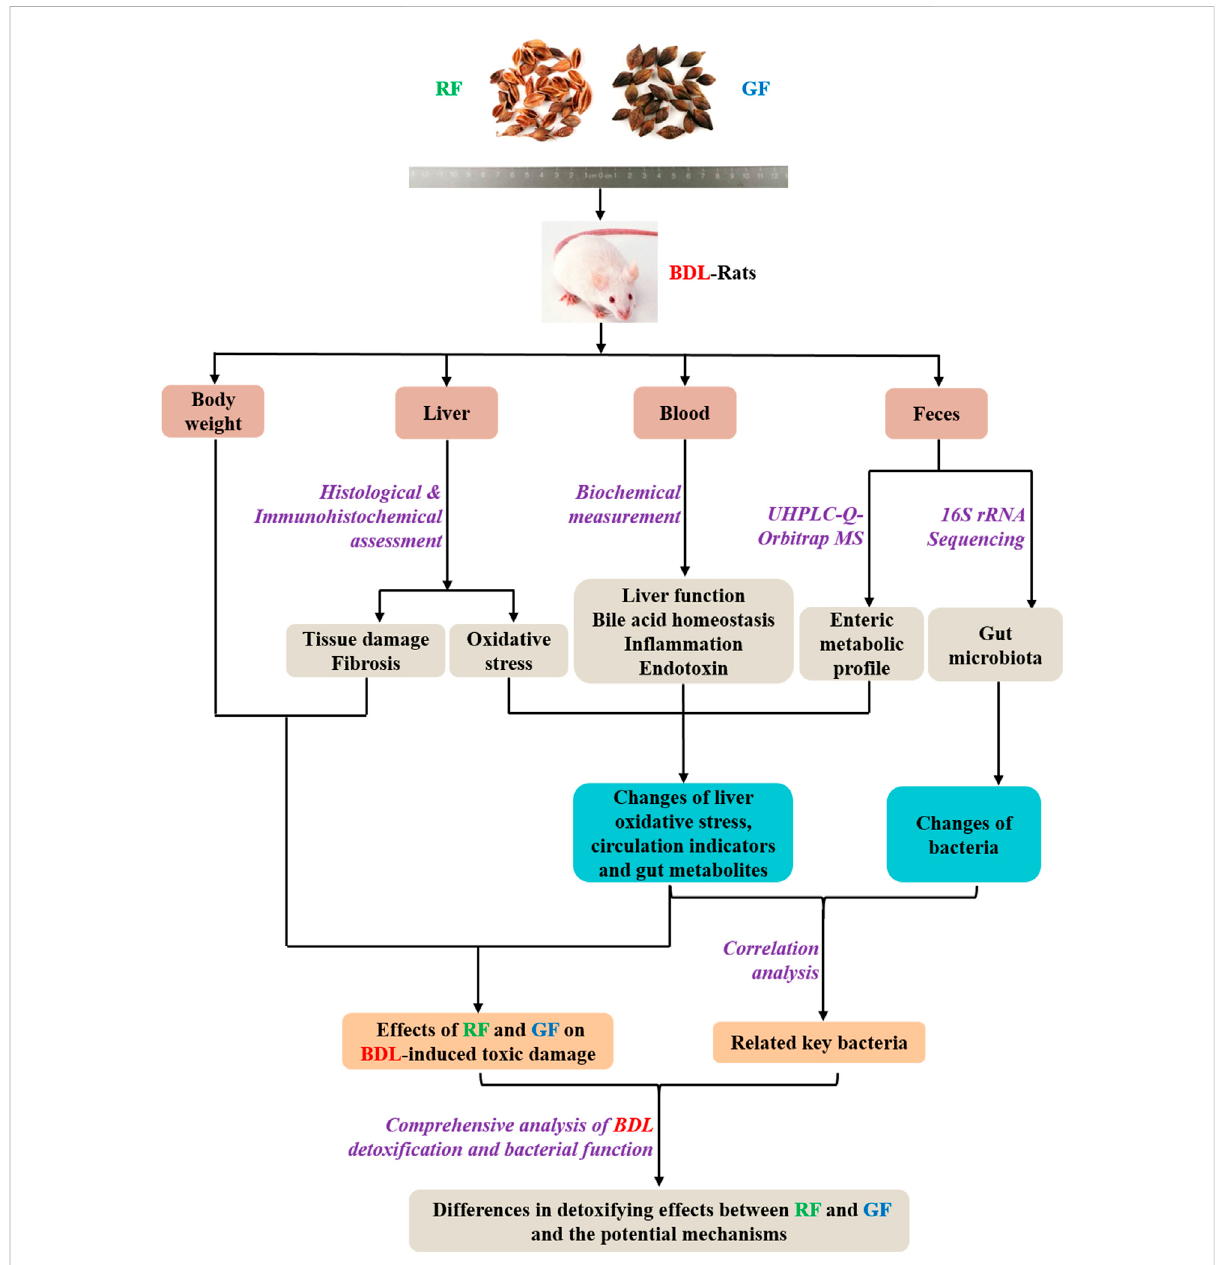
FIGURE 1 Research scheme for investigating the differences in detoxifying effects between RF and GF and the potential